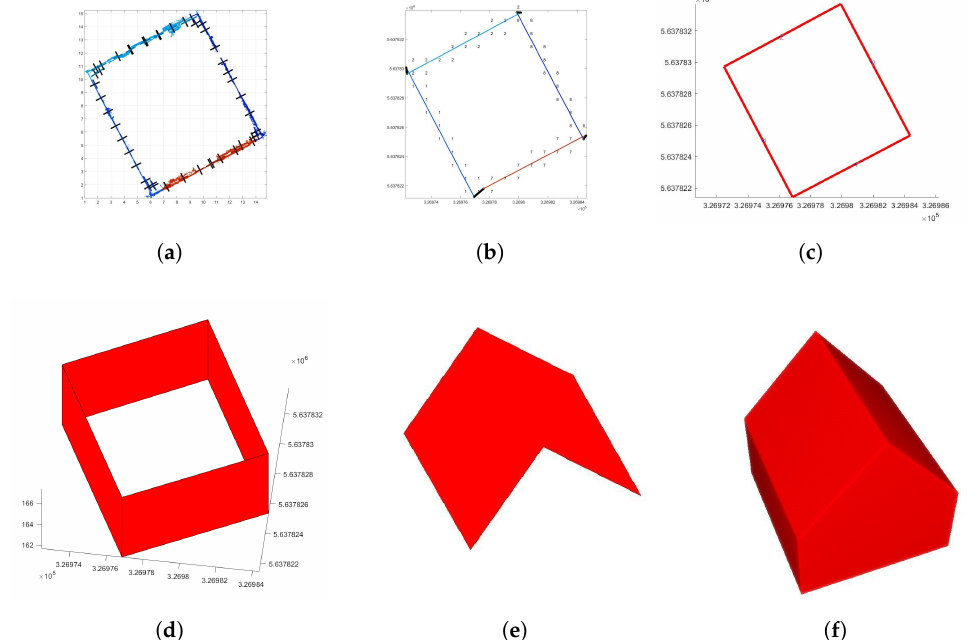
Figure 11. 3D building vector model reconstruction: ( a ) point cloud voxel projected onto 2D grid; ( b ) calculated segments; ( c ) closed contour; ( d ) erected contour; ( e ) roof structures; ( f ) complete 3D vector model. The segmented ground plan parts in ( a , b ) are highlighted by random colors before accumulation in ( c